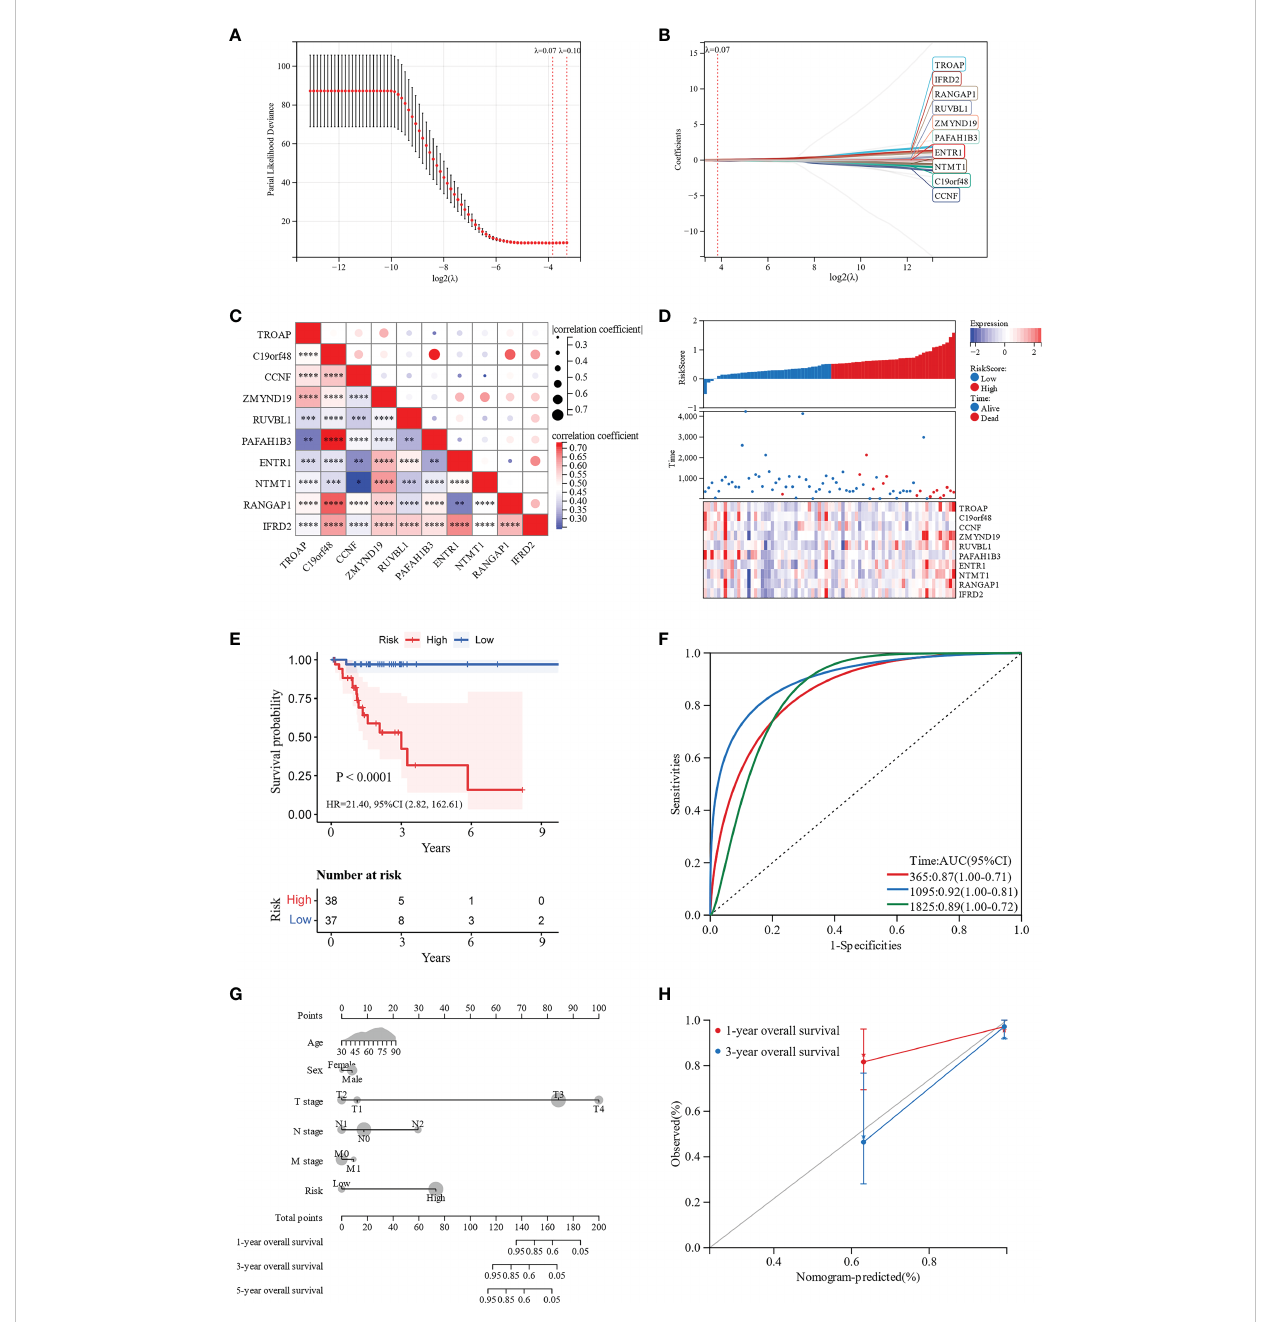
FIGURE 5 Development and validation of a 10 hub genes-based signature and a nomogram for prognostic prediction. (A, B) LASSO regression analysis was performed to develop the prognostic signature. (C) Correlation heatmap of the 10 hub genes. (D) The distribution of risk scores in patients with MAC. (E) Kaplan-Meier survival curves for the low-risk and high-risk groups. (F) ROC curves for the 10-genes signature. (G) Nomogram for predicting 1-, 3-, and 5-year OS of patients with MAC. (H) Calibration curve for the nomogram predicting 1- and 3-year OS with the ideal model. *p < 0.05. **p < 0.01. ***p < 0.001. ****p <